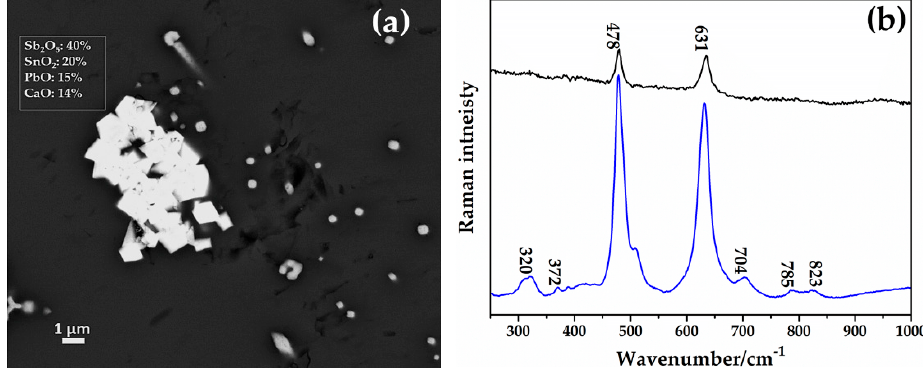
Figure 24. ( a ) FEG–SEM micrograph showing aggregates of CaSb 2 O 7 in sample AR2. ( b ) Raman spectra of two CaSb 2 O 7 (calcium antimonate) detected in the sample AR2.